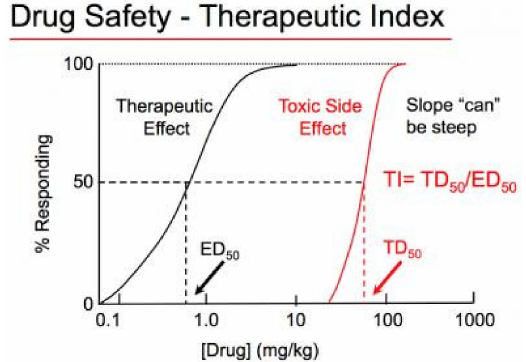
Figure 17. Schematic of drug safety-therapeutic index.